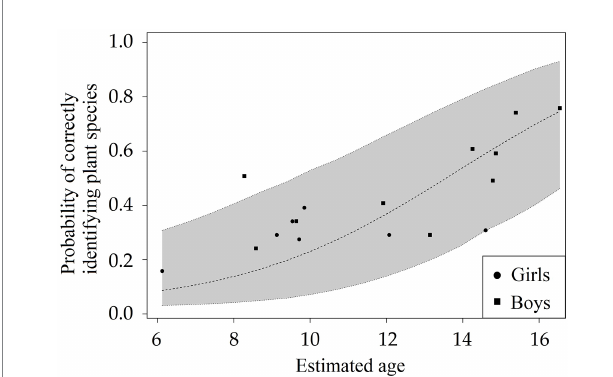
FIGURE 3 Botanical knowledge acquisition of foraging-related plant species during childhood. The relationship between age and the children’s ( N = 17) probability to correctly answer 60 questions, in which they were asked to give the name of 12 foraging-related plant species based on pictures of different parts (i.e., fruit/seed, trunk, leaf, bark) and of the actual dried leaves. Data from girls are indicated with circles and data from boys with squares.